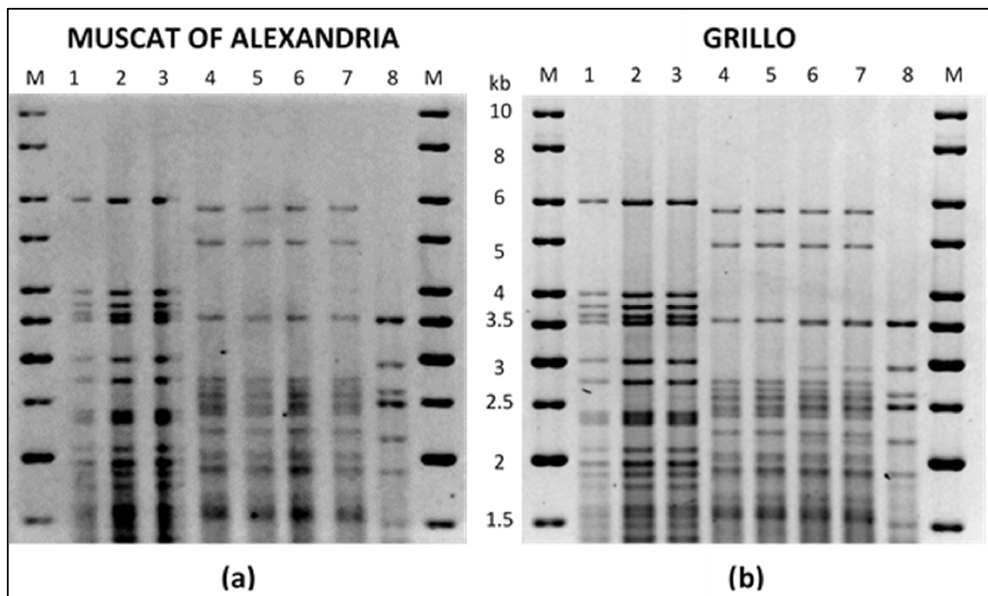
Figure 5. mt-DNA RFLP of yeasts present at the end of fermentations of Muscat of Alexandria ( a ) and Grillo ( b ) musts. Strain S. cerevisiae Lalvin QA23 ( lanes 1 ); yeast lees from vinifications inoculated with S. cerevisiae Lalvin QA23 ( lanes 2 and 3 ); yeast lees from spontaneous vinifications ( lanes 4 and 5 ); yeast lees from vinifications inoculated with K. marxianus Km L2009 ( lanes 6 and 7 ); strain K. marxianus Km L2009 ( lane 8 ). Molecular weight marker ( lanes M ).